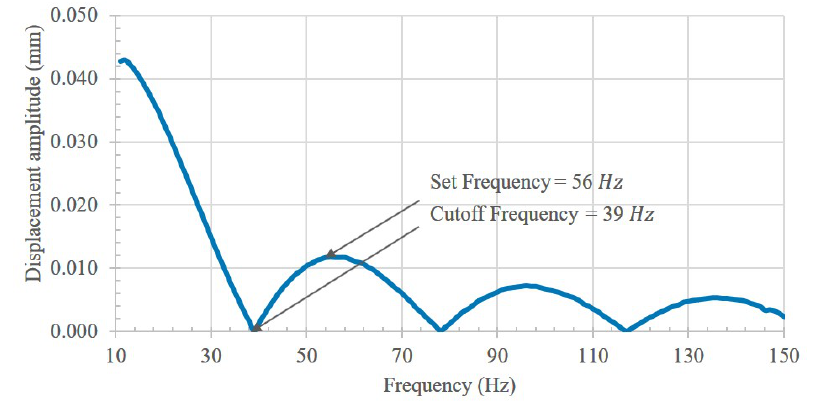
Figure 6. The frequency response of a specimen actuated at 0.100 volts control signal amplitude.